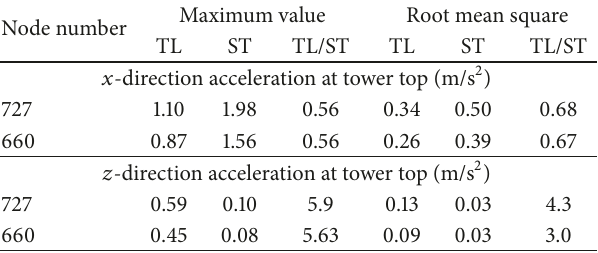
Table 9: Comparison of the dynamic analysis results of the acceler- ation at the top of the transmission tower for the single tower and the tower-line system under a wind speed of 𝑈 10 = 25.3